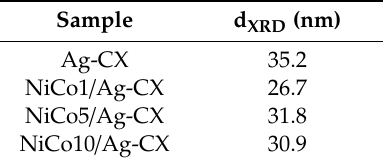
Table 2. The mean particle size (d XRD ) of the samples determined from the XRD data.